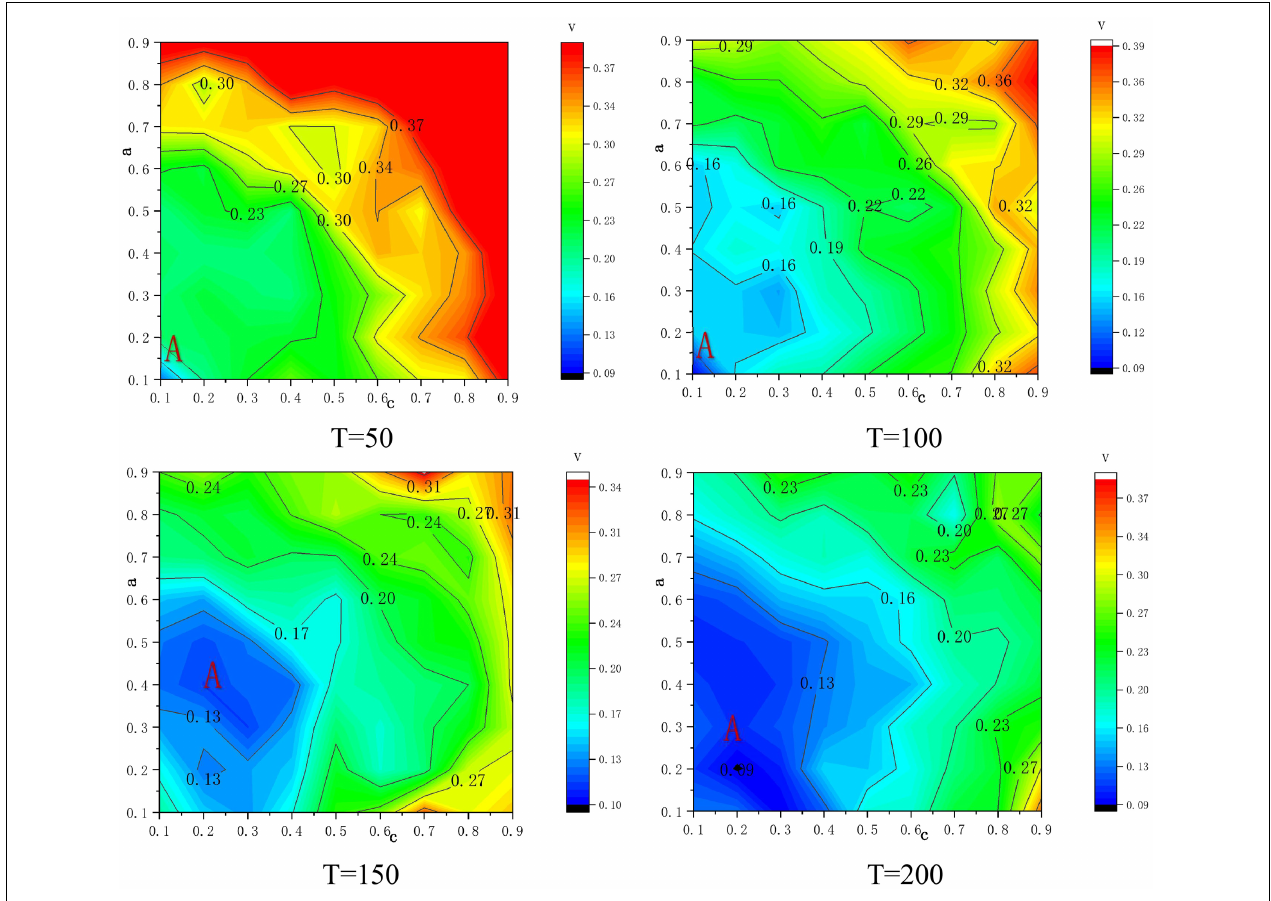
FIGURE 6 | The role of formal rule awareness and conformity mentality in different